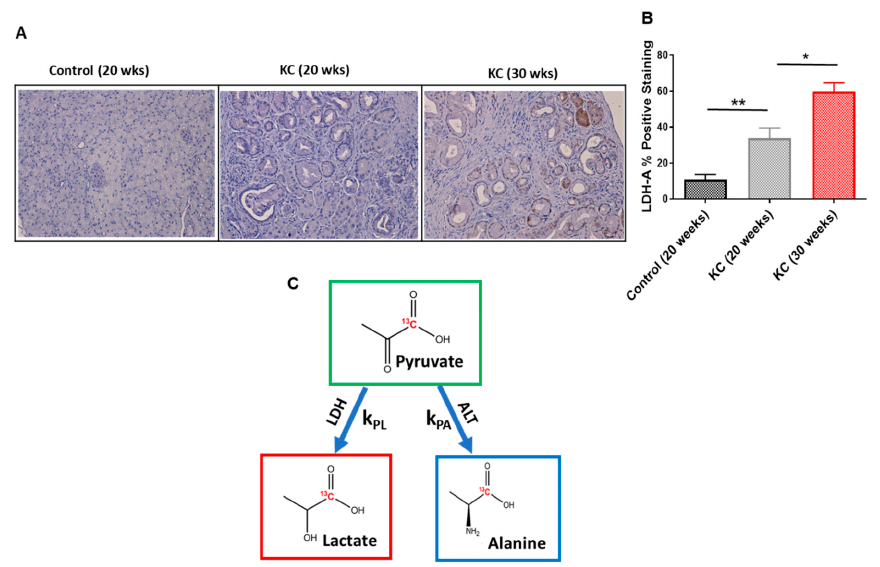
Figure 4. ( A ) Immunohistochemistry staining of LDH-A protein expression level for normal pancreas (control 20 wks) and early- (KC 20 wks) and advanced-stage (30 wks) PanINs. ( B ) Comparison of positive staining (%) scores among the tree di ff erent mice groups ( n = 10). The percentage of LDH-A positive staining significantly increases as the PanINs progress to advanced stage. ( C ) A schematic of conversion kinetics of pyruvate to lactate and alanine and the corresponding conversion rate constants (k PL and k PA ). The PanIN progression significantly alters these enzymatic kinetics. * means p < 0.05; ** means p <